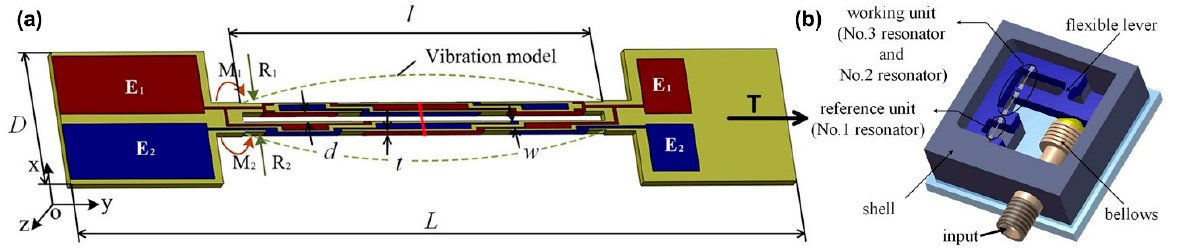
Figure 13. ( a ) Schematic diagram of the structure and electrode arrangement of quartz double-ended tuning fork (DETF). ( b ) The main structure diagram of the sensor. Reprinted/adapted with permission from Ref. [107]. Copyright 2019, AIP Publishing. Table 6. Efficient resonant action pressure sensors performance